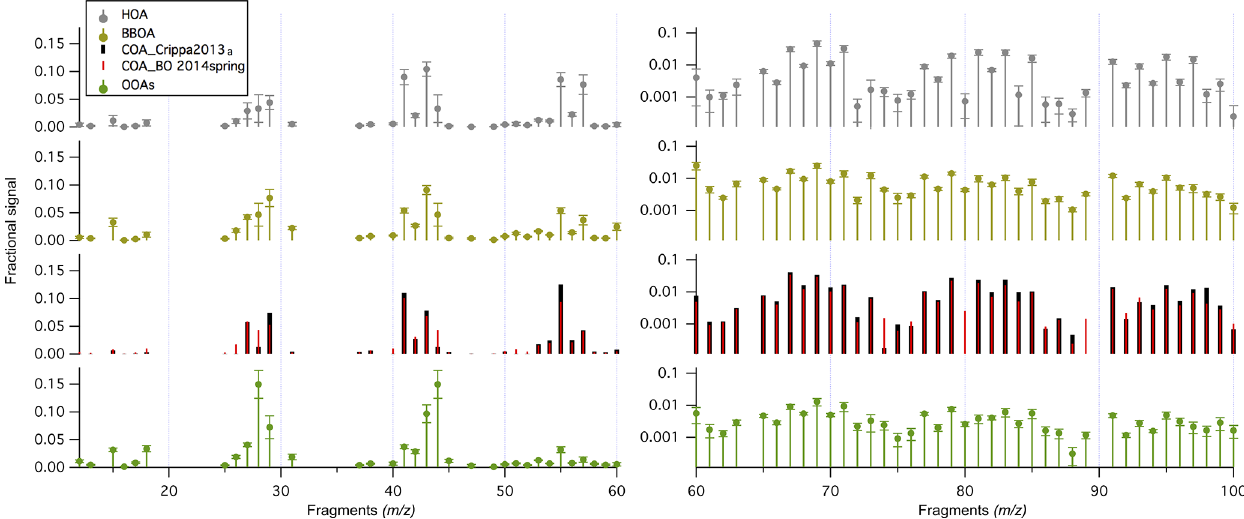
Figure 3. Mass spectral variability for the main retrieved OA sources. Mean values are represented with circles and the ± standard deviation with error bars. COA from the BO spring 2014 campaign is represented in red color over-imposed on the COA reference spectrum from Crippa et al.